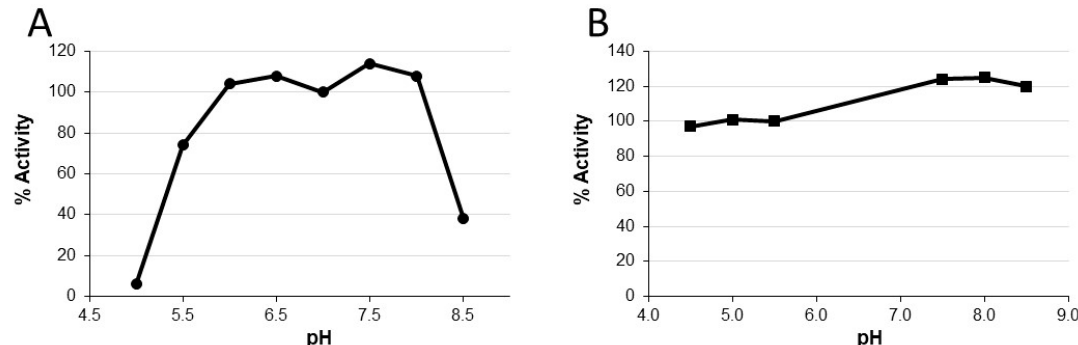
Figure 4. P2A biological activity under differing pH conditions. ( A ) P2A was incubated in assay